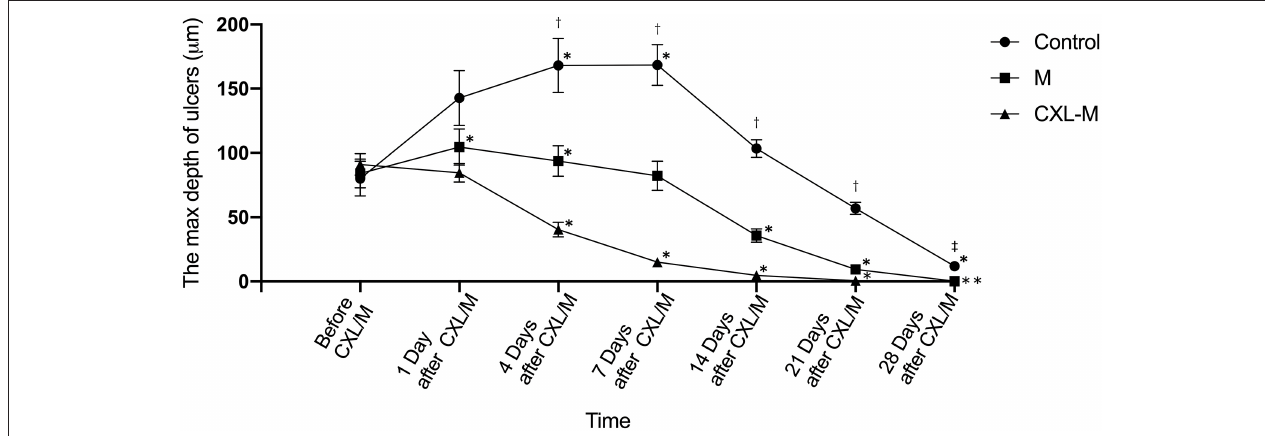
FIGURE 4 | The depth of corneal ulcer in three groups. *The corneal ulcer depth was significantly different at different follow-up time point in each group compared with that before treatment ( P < 0.05 for all). † There were significant differences in the depth of corneal ulcer between each group at one follow-up time point ( P < 0.05 for all). ‡ There were significant differences in the depth of corneal ulcer between control group and other two groups ( P < 0.05).